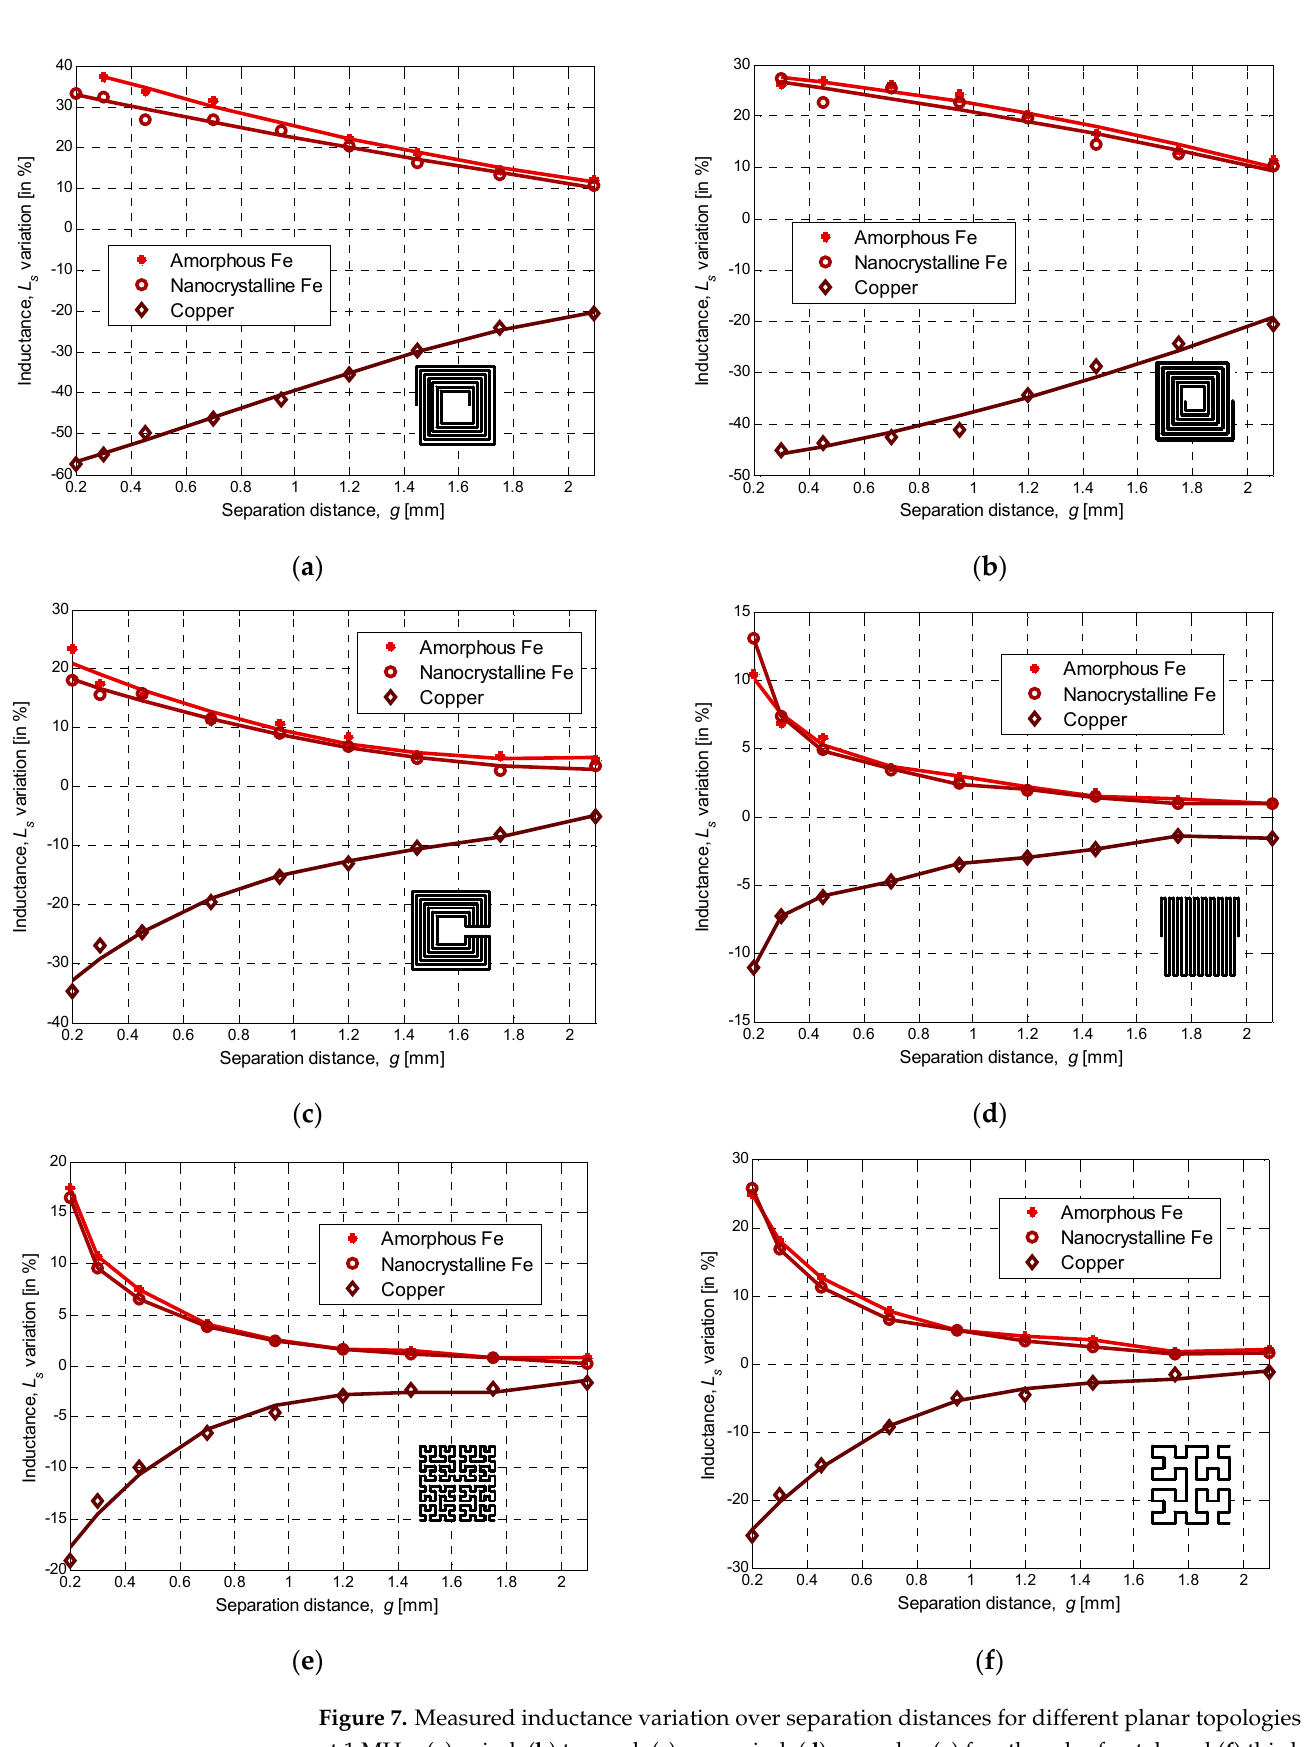
Figure 7. Measured inductance variation over separation distances for different planar topologies at 1 MHz: ( a ) spiral, ( b ) tapered, ( c ) non-spiral, ( d ) meander, ( e ) fourth-order fractal, and ( f ) third-order fractal.